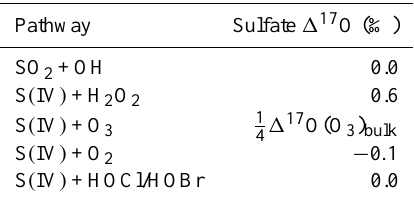
Table 2. Sulfate model isotope assumptions.